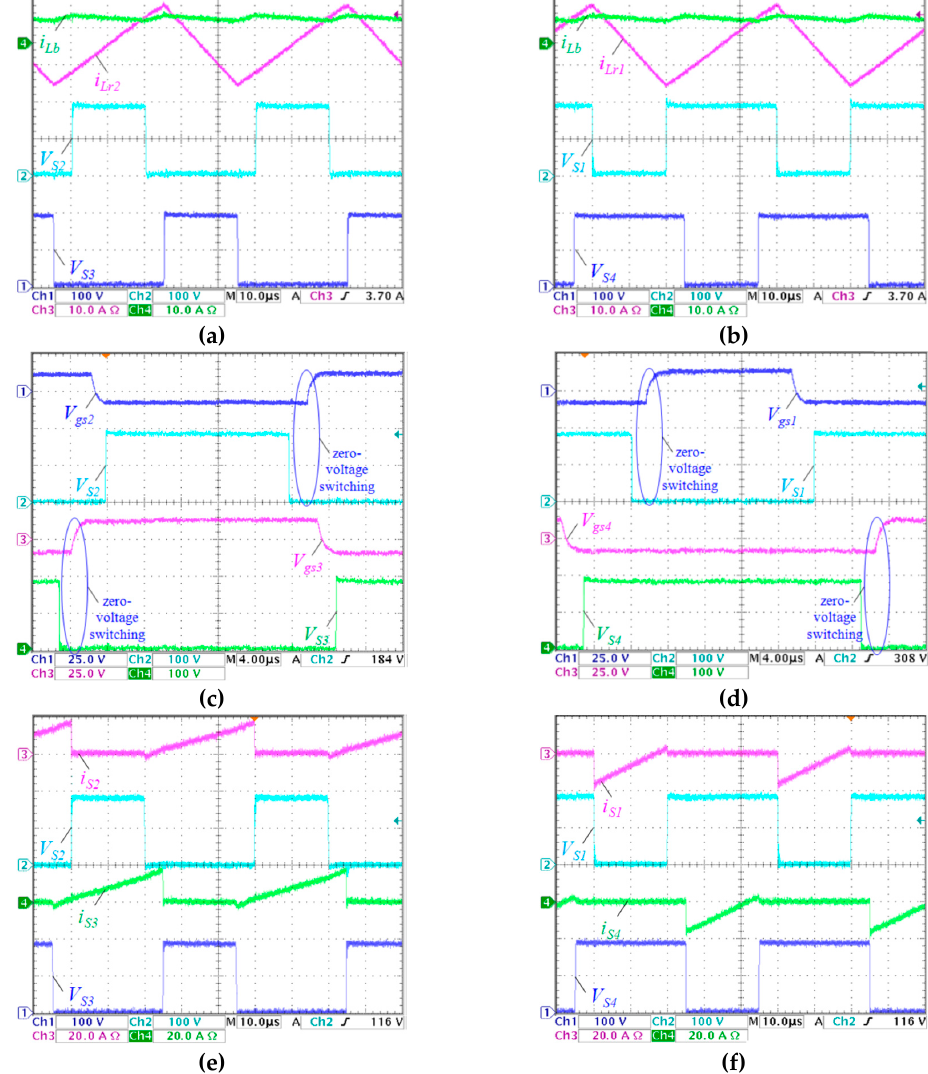
Figure 9. The experimental waveforms of the proposed converter in the step-up mode: ( a ) i Lb , i Lr2 , V S2 , and V S3 ; ( b ) i Lb , i Lr1 , V S1 , and V S4 ; ( c ) V gs2 , V S2 , V gs3 , and V S3 ; ( d ) V gs1 , V S1 , V gs4 , and V S4 ; ( e ) i S2 , V S2 , i S3 , and V S3 ; ( f ) i S1 , V S1 , i S4 , and V S4 .